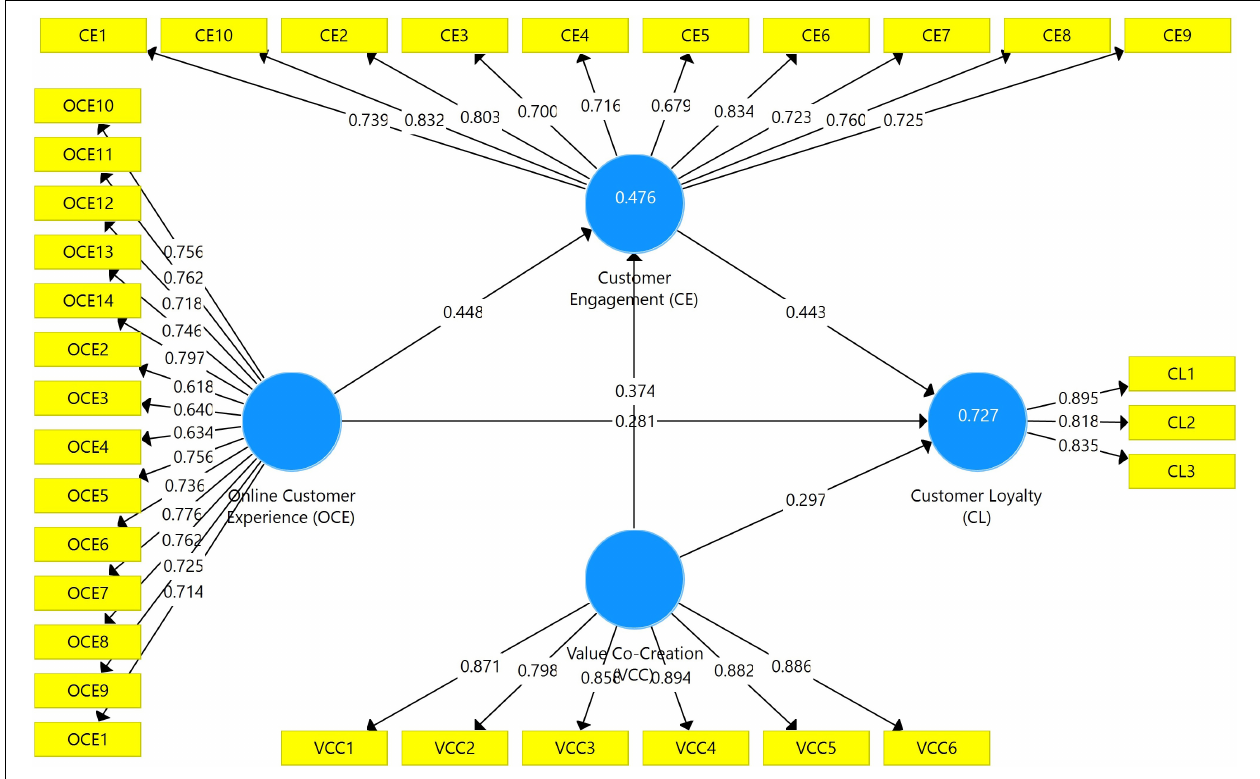
Figure 2 . Cronbach’s Alpha ( > 0.700), composite reliability ( > 0.700), and average variance extracted (AVE) values over 0.500 fulfilled the minimal standards, as shown in